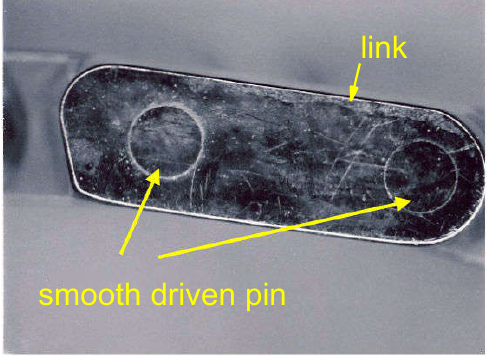
19 of 26 Figure 29. Corrosion in the grooves of the knurled pin after 45 cycles. Scale = 100 μm. Sample #7. 3.3. The Tuccillo–Nielsen Test